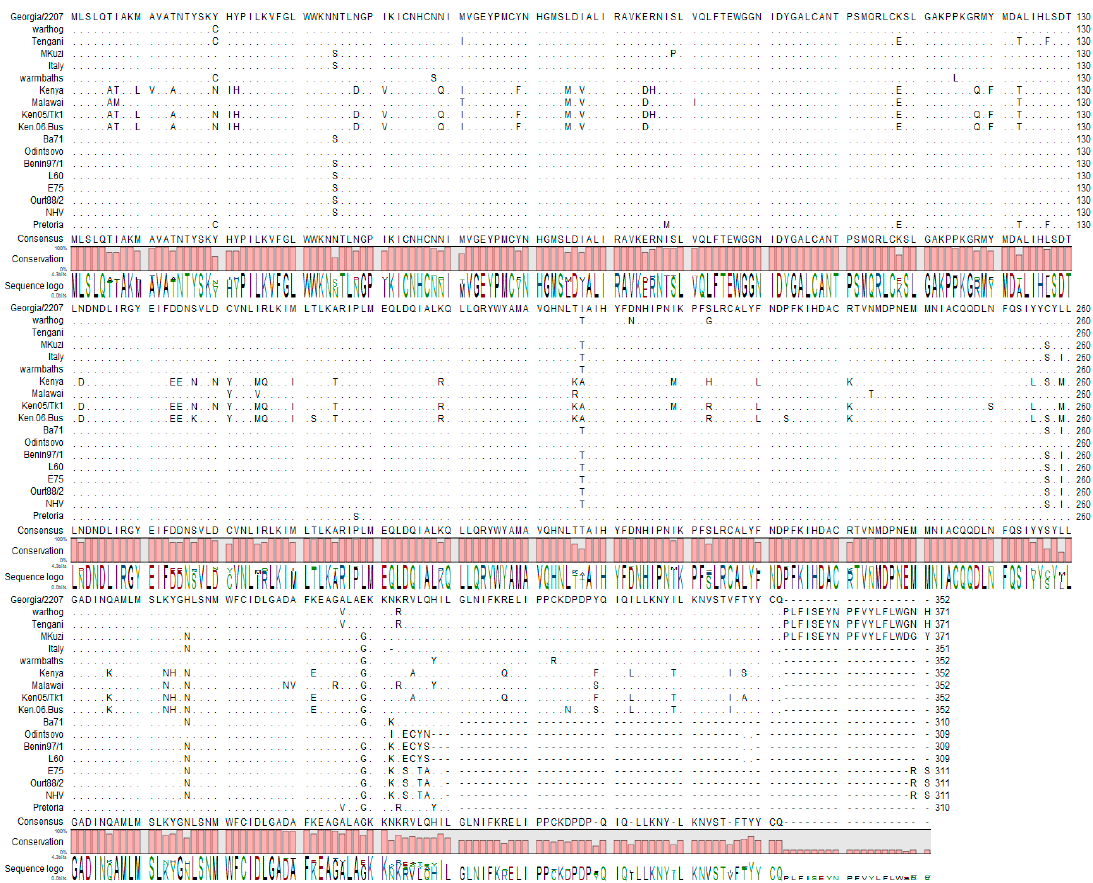
Figure 2. Multiple sequence alignment of the indicated ASFV isolates of viral protein MGF360-16R. Matching residues are represented as dots. The degree of conservation is presented below the protein sequence, and the conserved residue is presented on the bottom, indicating the degree of conservation for particular amino acids in the protein sequence.